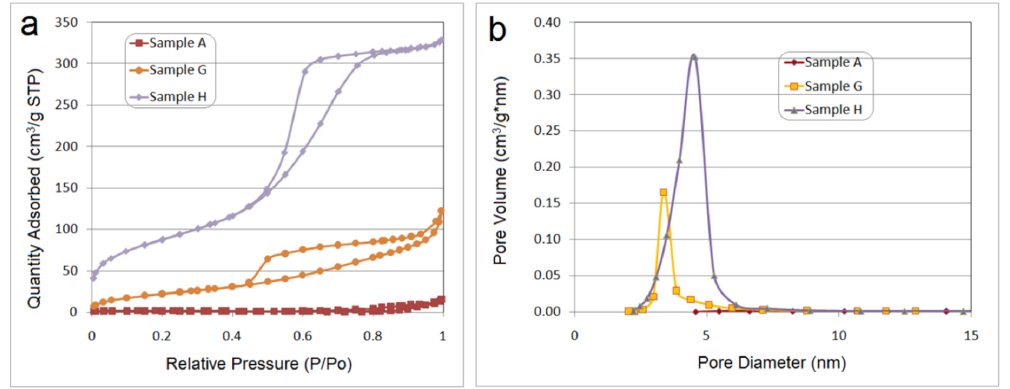
Table 2. Nitrogen physisorption data. Sample No.